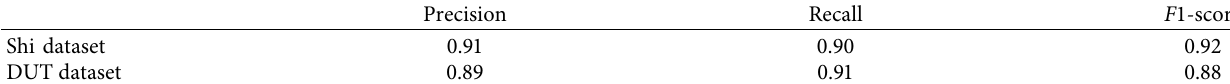
Table 1: Precision, recall, and F 1-score of the proposed method.